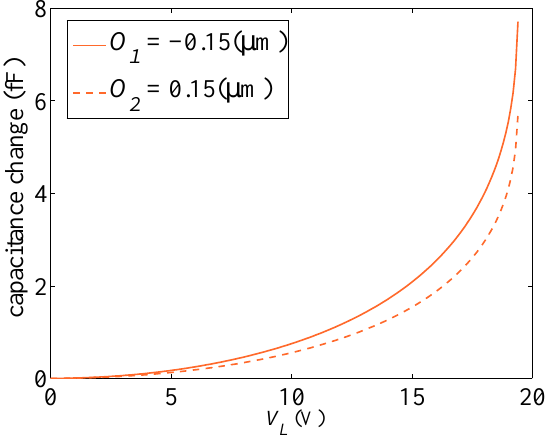
Figure 5. Sensitivity of the pull-in voltages V pull ( right ) the polysilicon Young’s modulus E .